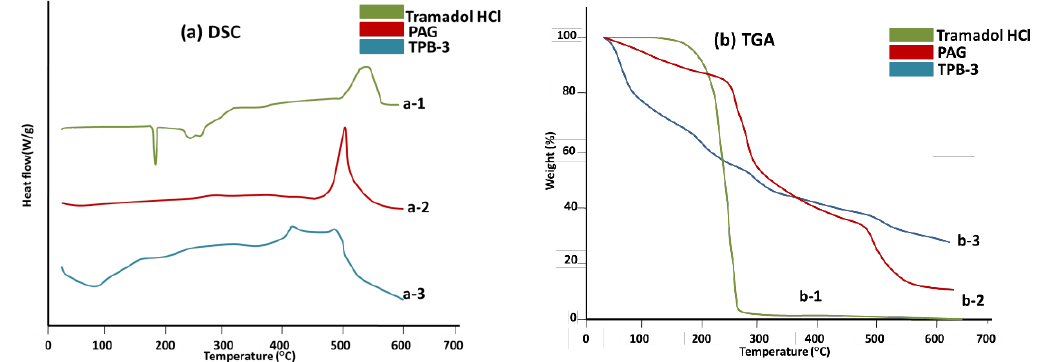
Figure 11. Thermal analysis: ( a ) DSC thermograms of(a-1), pure TRHC; (a-2) PAG and (a-3) TRHC loaded PAG-alginate microspheres ( b ) TGA curves of (b-1) pure TRHC; (b-2) PAG; and (b-3) TRHC loaded PAG-alginate microspheres.